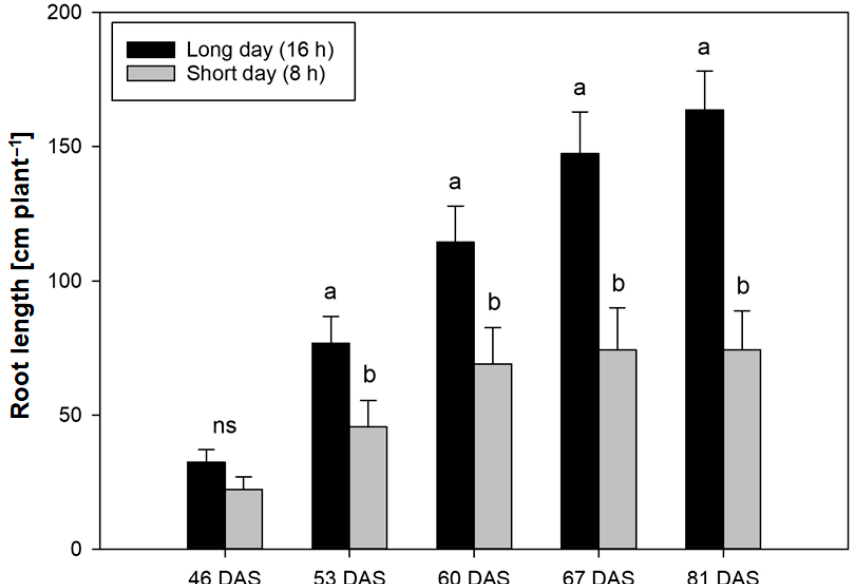
Figure 2. Intermediate root length measurement of yellow maca plants grown in rhizoboxes under controlled conditions at long (16 h) or short (8 h) day length. The measurements were performed at 46, 53, 60, 67, and 81 DAS. Results represent mean values ± SEM of three independent replicates. Different letters indicate significant differences between treatments ( p ≤ 0.05), ns = not significant.